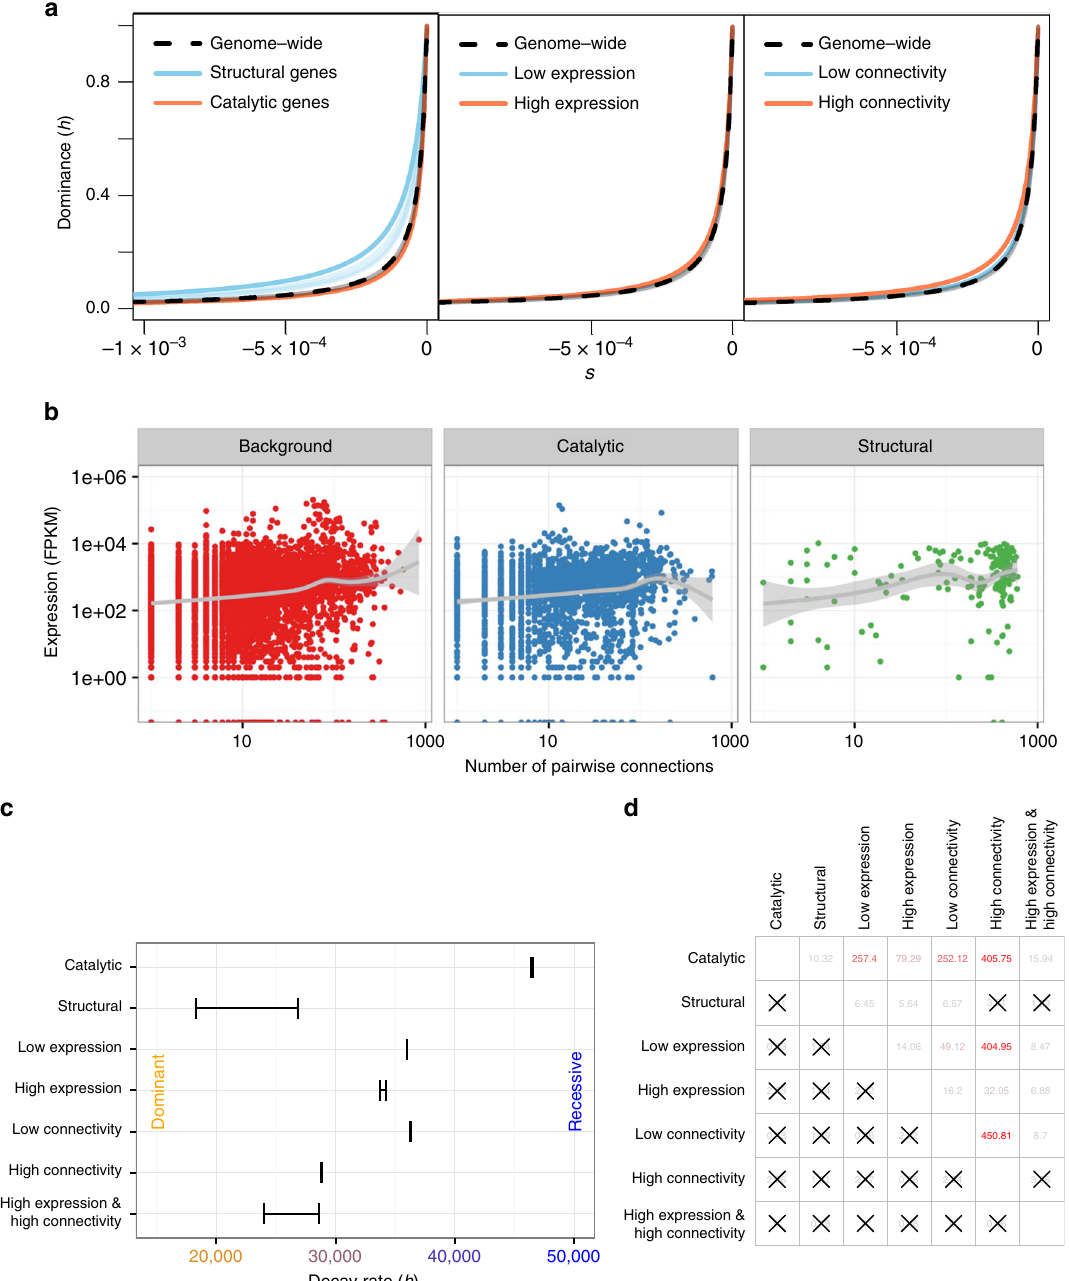
Fig. 4 Distribution of dominance per gene category. a h – s relationship inferred for different gene categories. Bootstrap replicates are shown in lighter colors and in gray for the genome-wide estimates. The blue lines in the middle and right panel strongly overlap with the gray lines of the genome-wide estimates. b Expression pro fi les are correlated with gene connectivity. Note that structural genes have higher connectivity and expression than do other types of genes. Background refers to genes not in catalytic or structural GO categories. c Differences in the decay rate of h ( θ rate ) across gene categories. 95% con fi dence intervals (CI) are shown. Larger decay rates indicate that for a given value of s , mutations tend to be more recessive. d Z -scores for tests of differences in decay rate (upper triangle) and intercept (lower triangle) between different categories of genes. Color indicates degree of signi fi cance (red is more signi fi cant). Comparisons not signi fi cantly different after Bonferroni correction are denoted by “ X ”